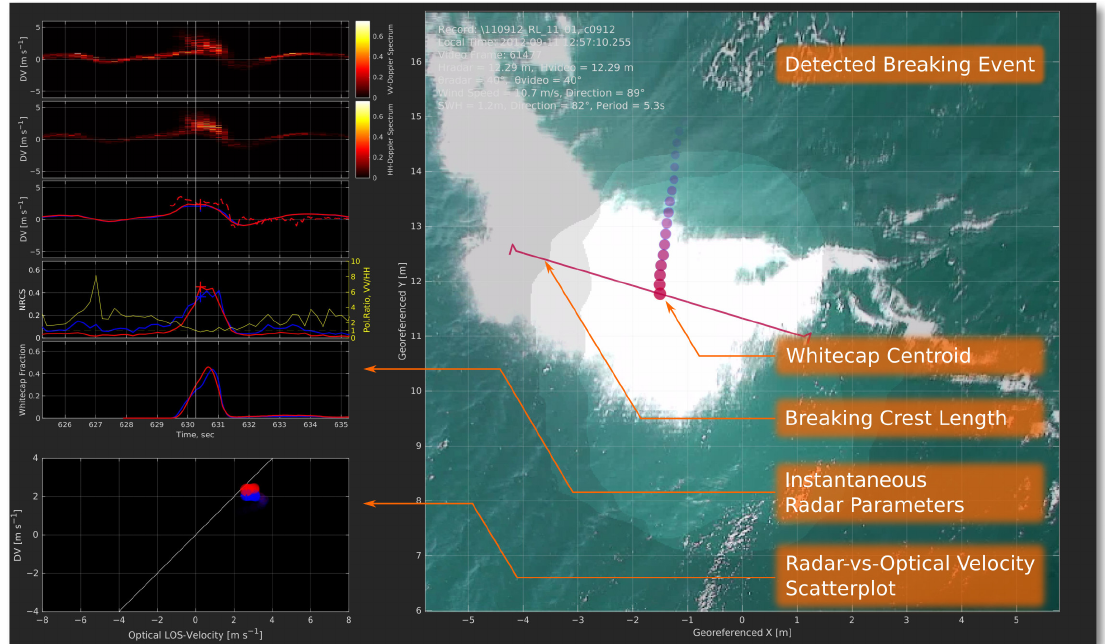
Figure 1. An example of joint radar–video processing. The ( left ) plots show the instantaneous VV, HH Doppler spectra, instantaneous Doppler velocity (DV), breaker optical line-of-sight velocity (LOV), VV and HH footprint RCS and their ratio, footprint fraction covered by whitecaps, and scatterplot between DV and LOV (blue—VV, red—HH, yellow—VV/HH-ratio). The ( right ) image shows the projected geo-referenced video frame with the detected whitecap, the time evolution of its geometric centroid points (which demonstrates the breaker trajectory and velocity; the frame rate is 25 fps), and the estimated breaking crest length. Radar footprints for VV and HH polarizations at the minus 3 dB level are